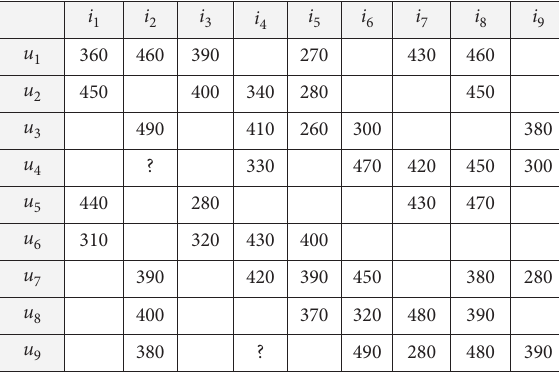
Figure 2: A 9 × 9 user-item matrix of response time